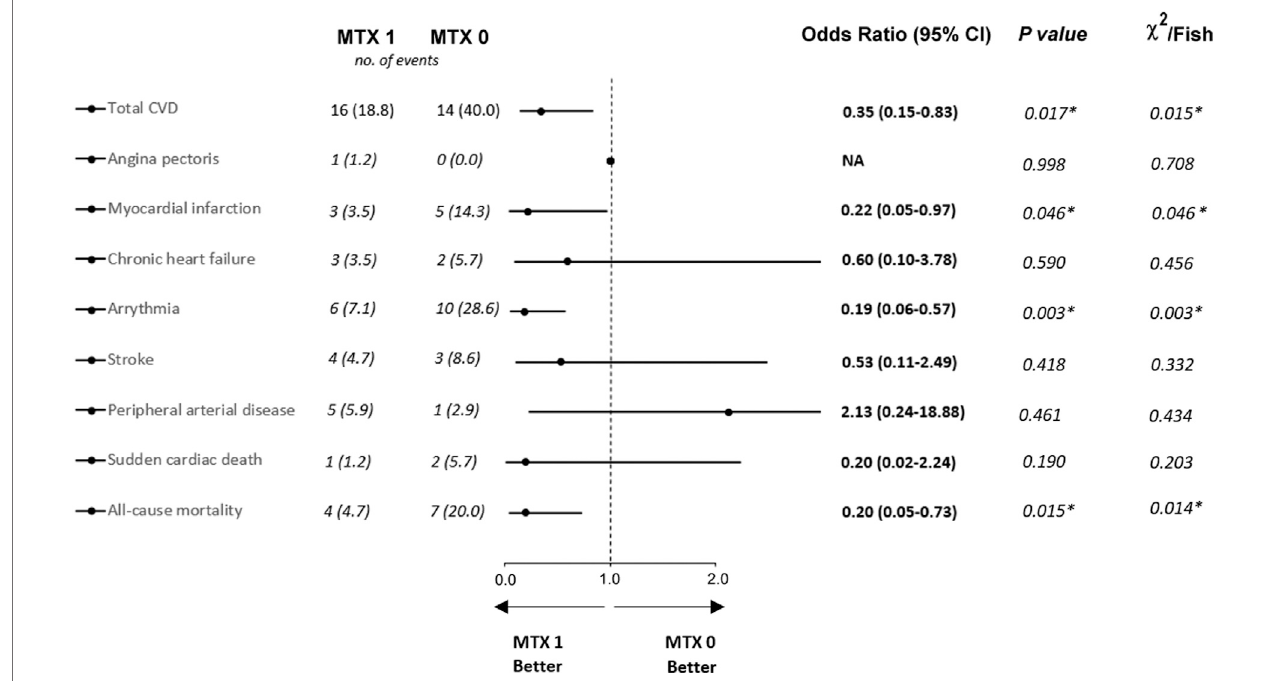
FIGURE2| Proportionofcardiovascular diseases and all-cause mortalitybetweengroups ofRApatients treated(MTX 1group) ornon-treated (MTX 0group) with MTX. *Values arestatistically signi fi cant( p < 0.05).Dataareavailable fromall 120patients (MTX1 n (cid:1) 85; MTX0 n (cid:1) 35). NA,not available; CVD,cardiovasculardisease; MTX 1, patients treated with MTX at the time of data collection; MTX 0, patients without MTX treatment at the time of data collection.